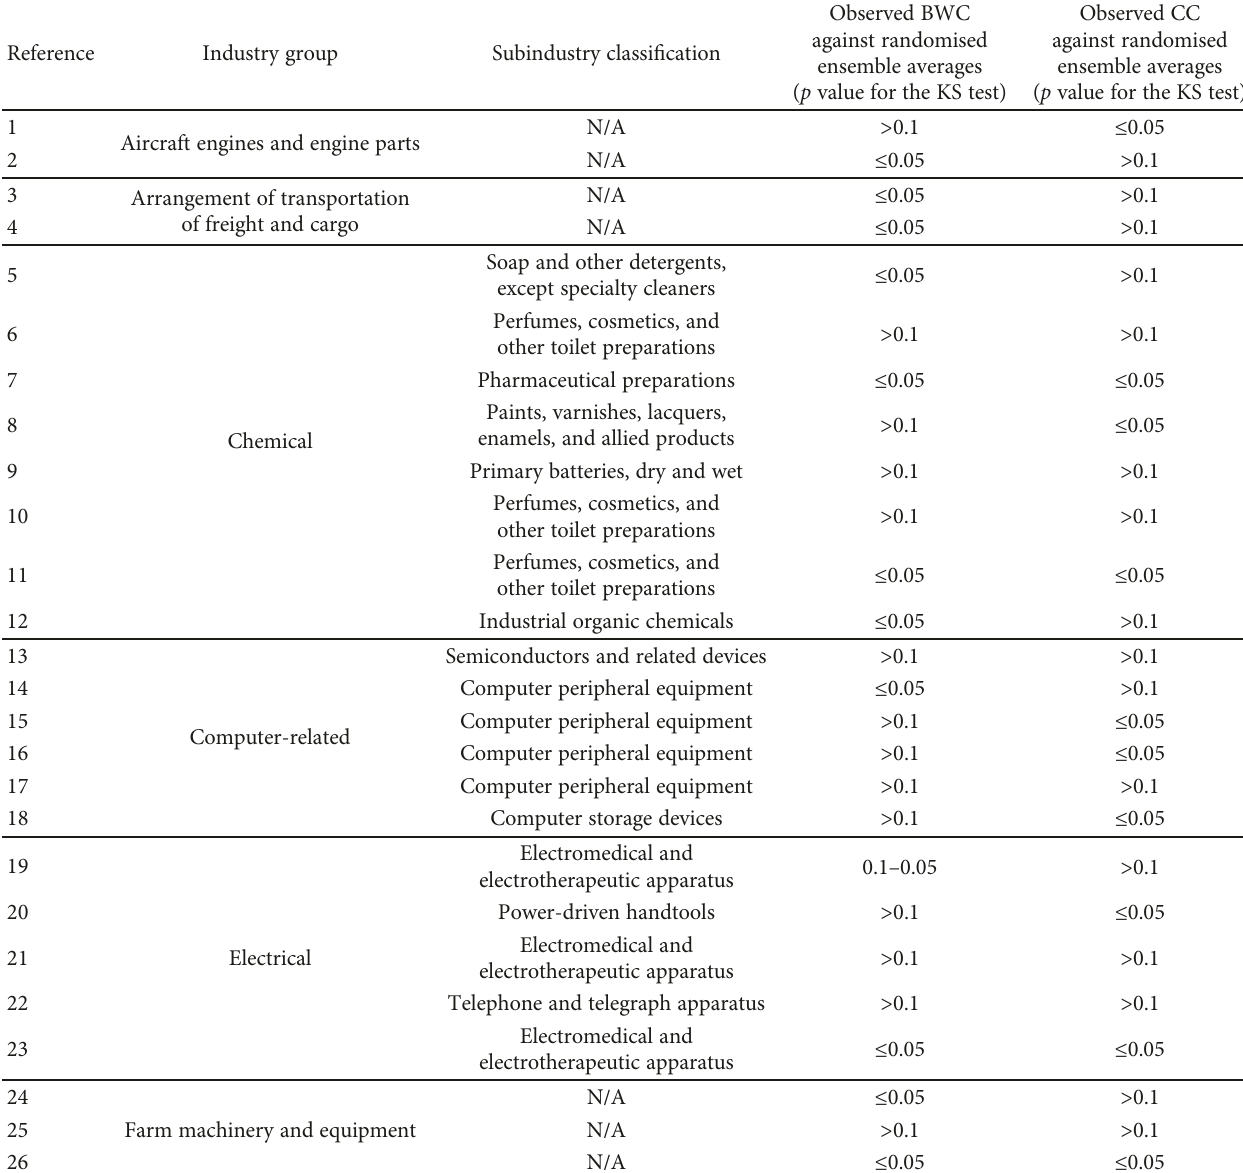
Table 4: p values obtained for the KS test for observed centrality distributions and the average centrality distributions obtained for 1000 randomised ensembles, for various